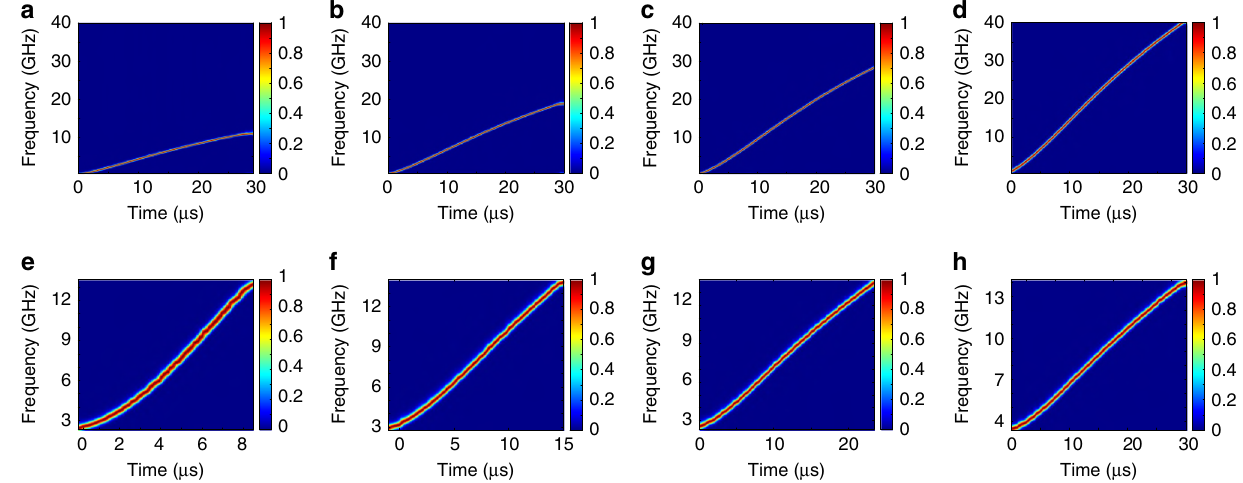
Fig. 5 Tuning of the generated LCMW with a tunable bandwidth. The bandwidth is a 10.2 GHz, b 20.1 GHz, c 27.9 GHz, and d 38.1 GHz, while maintaining the pulse duration at 30 µ s. Tuning of the generated LCMW with a duration of e 8.5 µ s, f 16.4 µ s, g 22.2 µ s, and h 30 µ s, while maintaining the pulse bandwidth around 11 GHz.